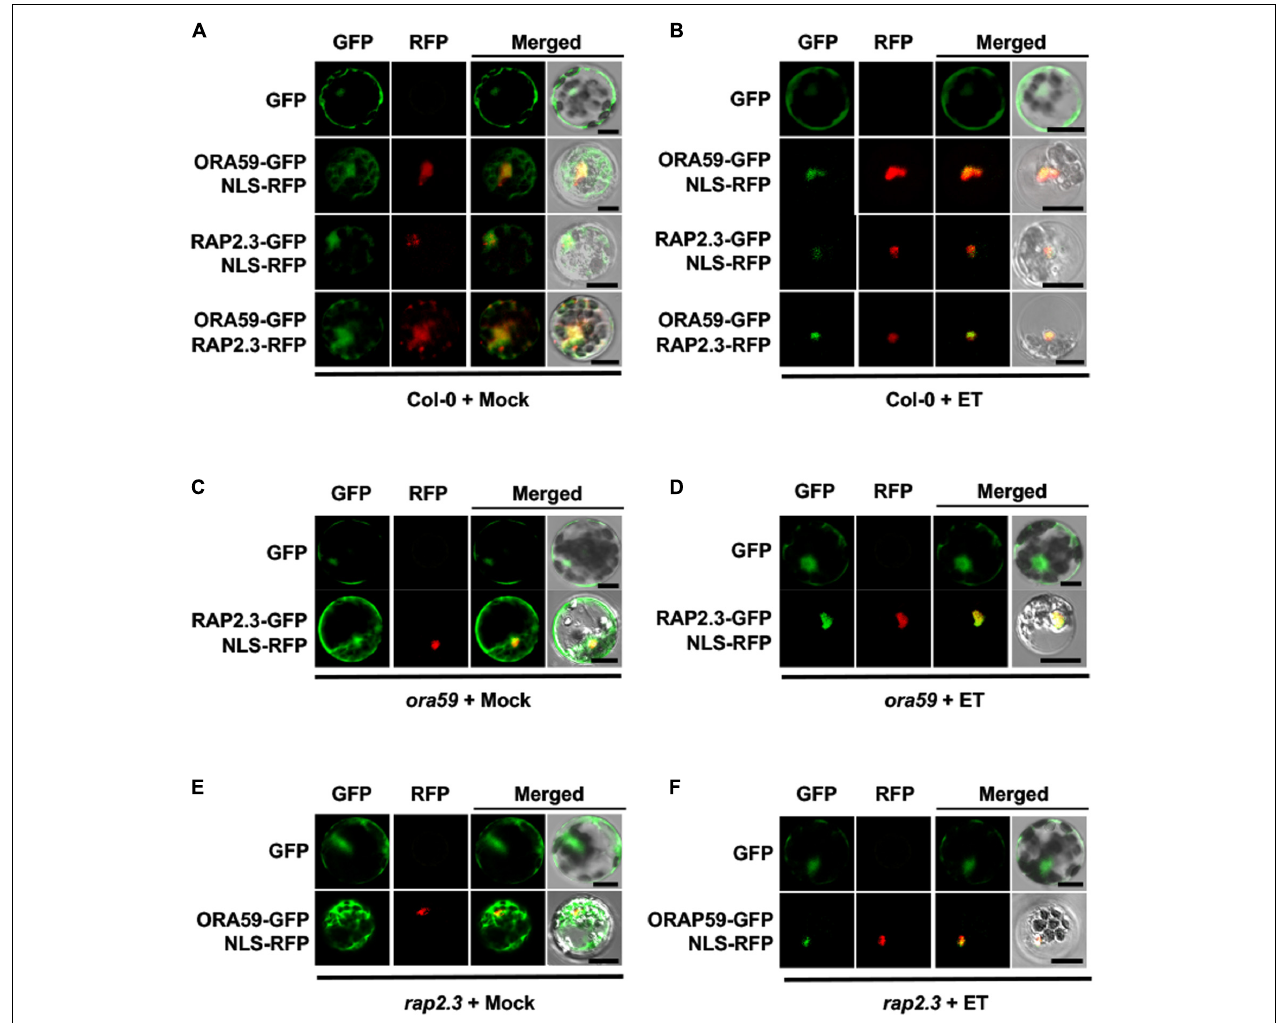
FIGURE 3 | ET-dependent nuclear co-localization of ORA59 and RAP2.3. (A,B) Subcellular localization of ORA59 and RAP2.3 in Col-0 protoplasts treated with 0.1% DMSO (mock) (A) or 1.5 mM ET (B) for 4 h. (C,D) Subcellular localization of ORA59 in rap2.3 protoplasts treated with 0.1% DMSO (mock) (C) or 1.5 mM ET (D) for 4 h. (E,F) Subcellular localization of RAP2.3 in ora59 protoplasts treated with 0.1% DMSO (mock) (E) or 1.5 mM ET (F) for 4 h. ORA59-GFP, RAP2.3-GFP, RAP2.3-RFP, and NLS-RFP were expressed in Arabidopsis protoplasts as indicated. Fluorescence signals were visualized under a confocal microscope. Bars, 10 µ m. Experiments were repeated three times with similar